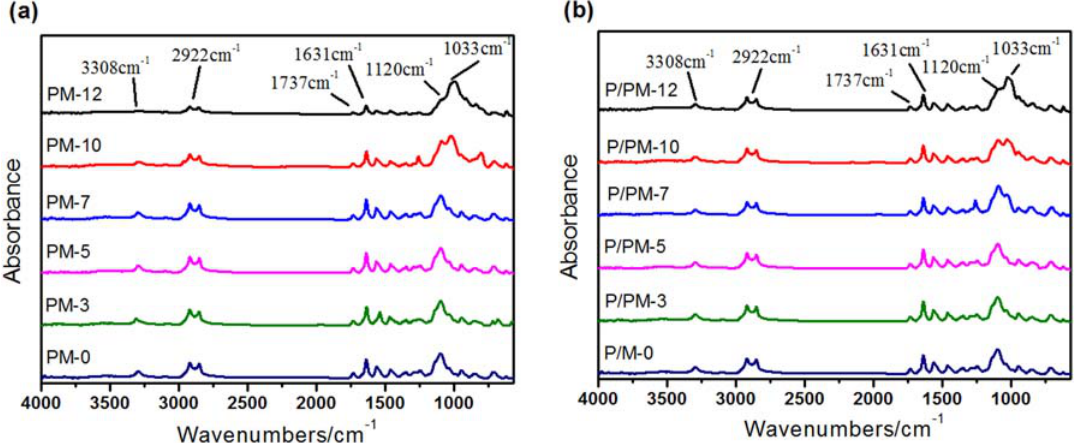
Figure 7: ATR - FTIR spectra of MMMs: ( a ) pristine MMT/PEBAX ® 1074, ( b ) APOP - MMT/PEBAX ®